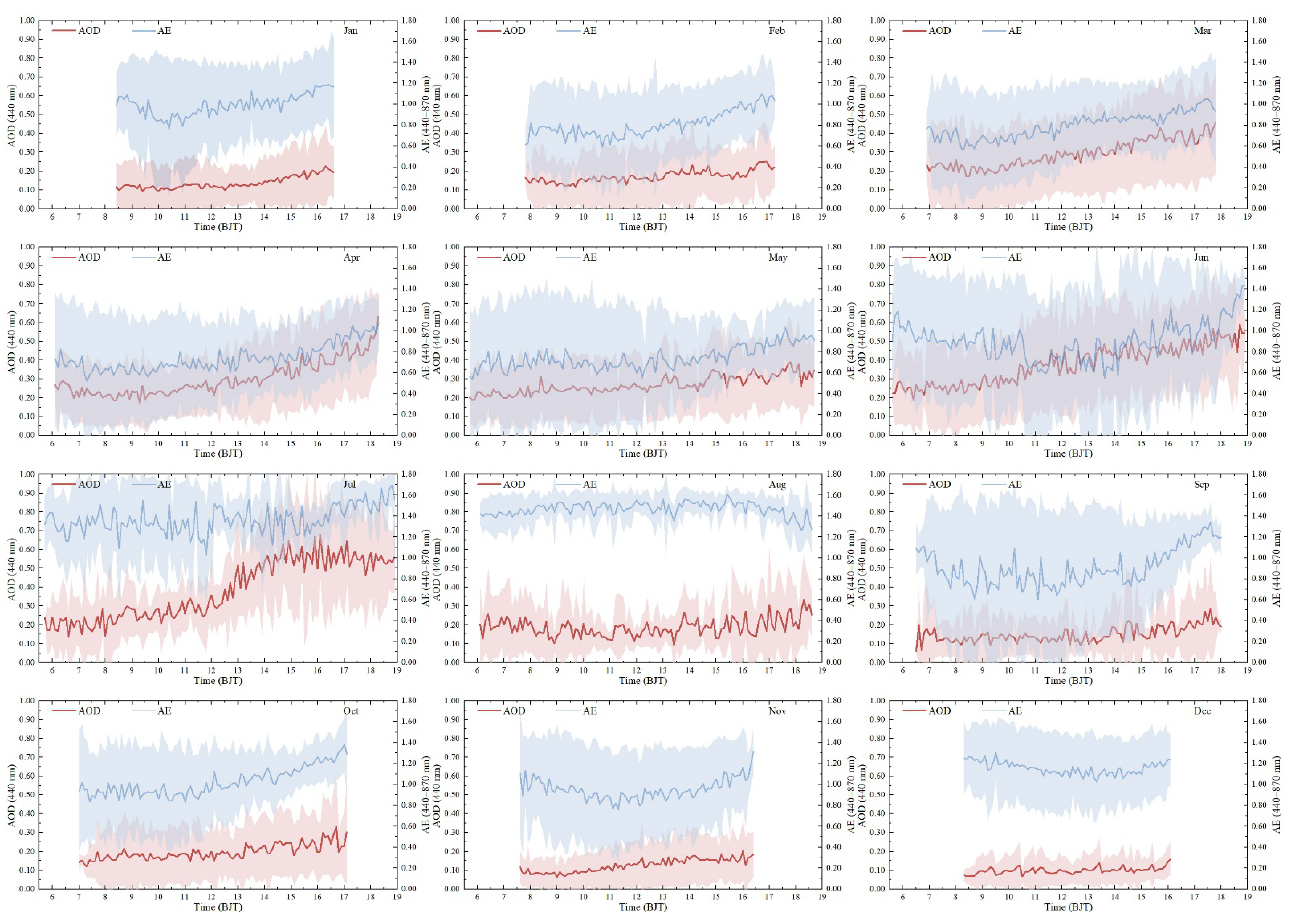
Figure 3. Diurnal variation of the hourly mean AOD 440 nm and Ångström exponent (440 − 870 nm) at the MFYD Observatory. The shaded areas represent the standard deviation. Table 1. Monthly mean statistics of the variation of the AOD at the MFYD Observatory. Daytime Morning